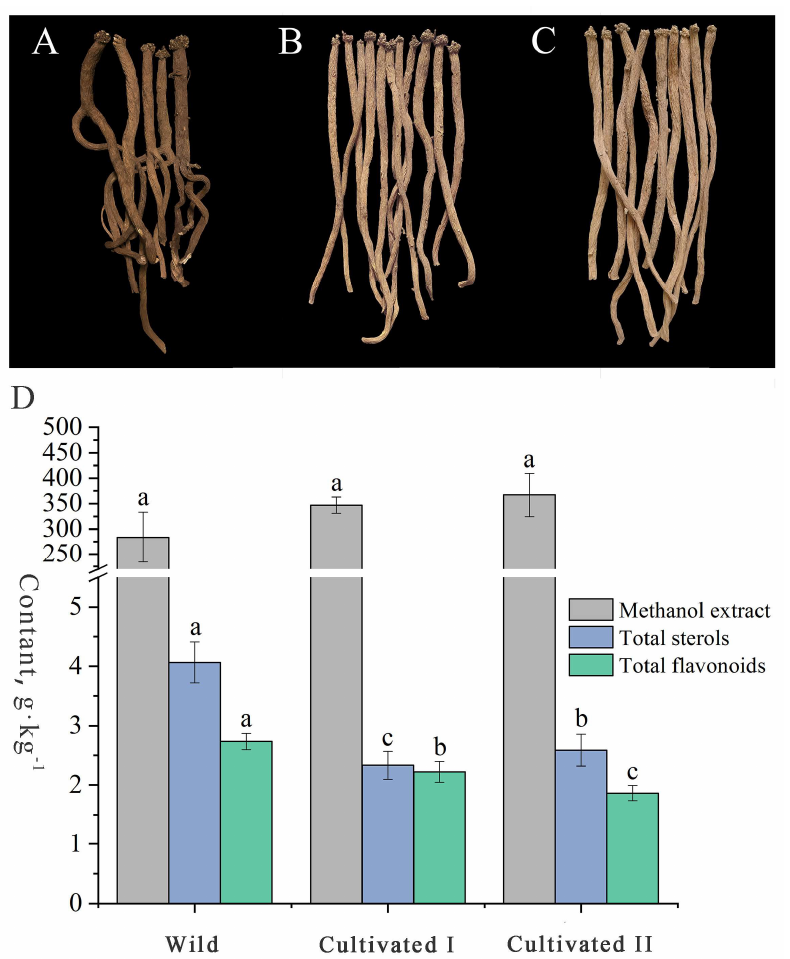
Figure 1. Characteristics and metabolite contents of the wild and cultivated YCH. ( A – C ) Overall characteristics of Wild (wild), Cultivated I and Cultivated II (cultivated), roots, respectively. ( D )The content of methanol extract, total sterols and total flavonoids of Wild, Cultivated I and Cultivated II, the lowercase letters in the figure indicate the significant difference between the samples ( p < 0.05), the same letter represents no significant difference, and different letters represent significant difference.